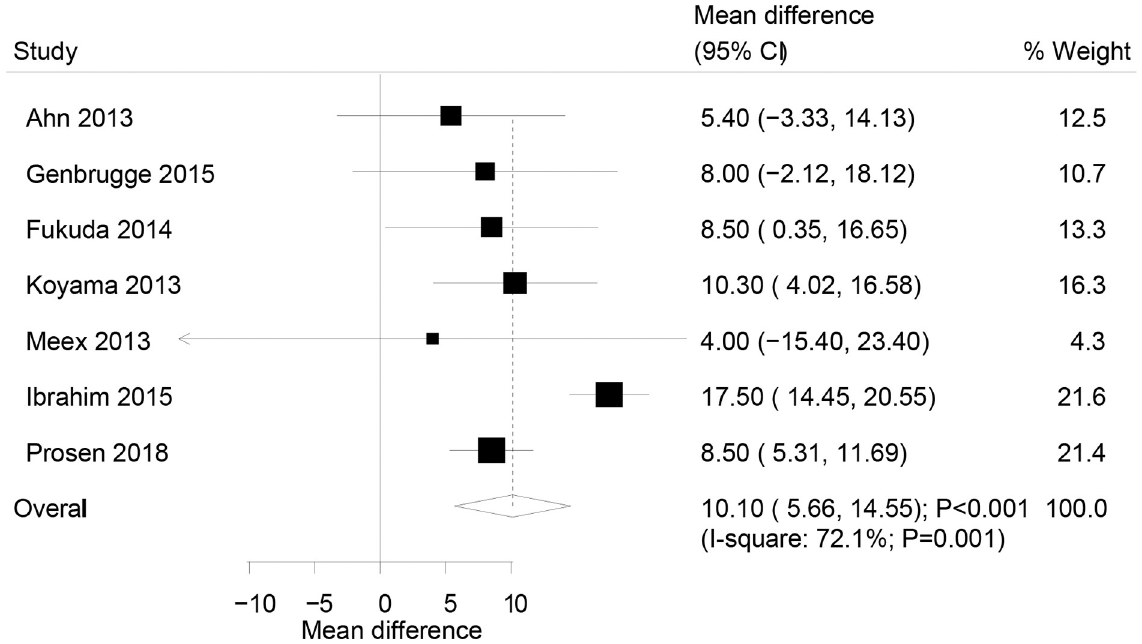
Fig 2. Association of the initial rSO2 level with the incidence of the return of spontaneous circulation.